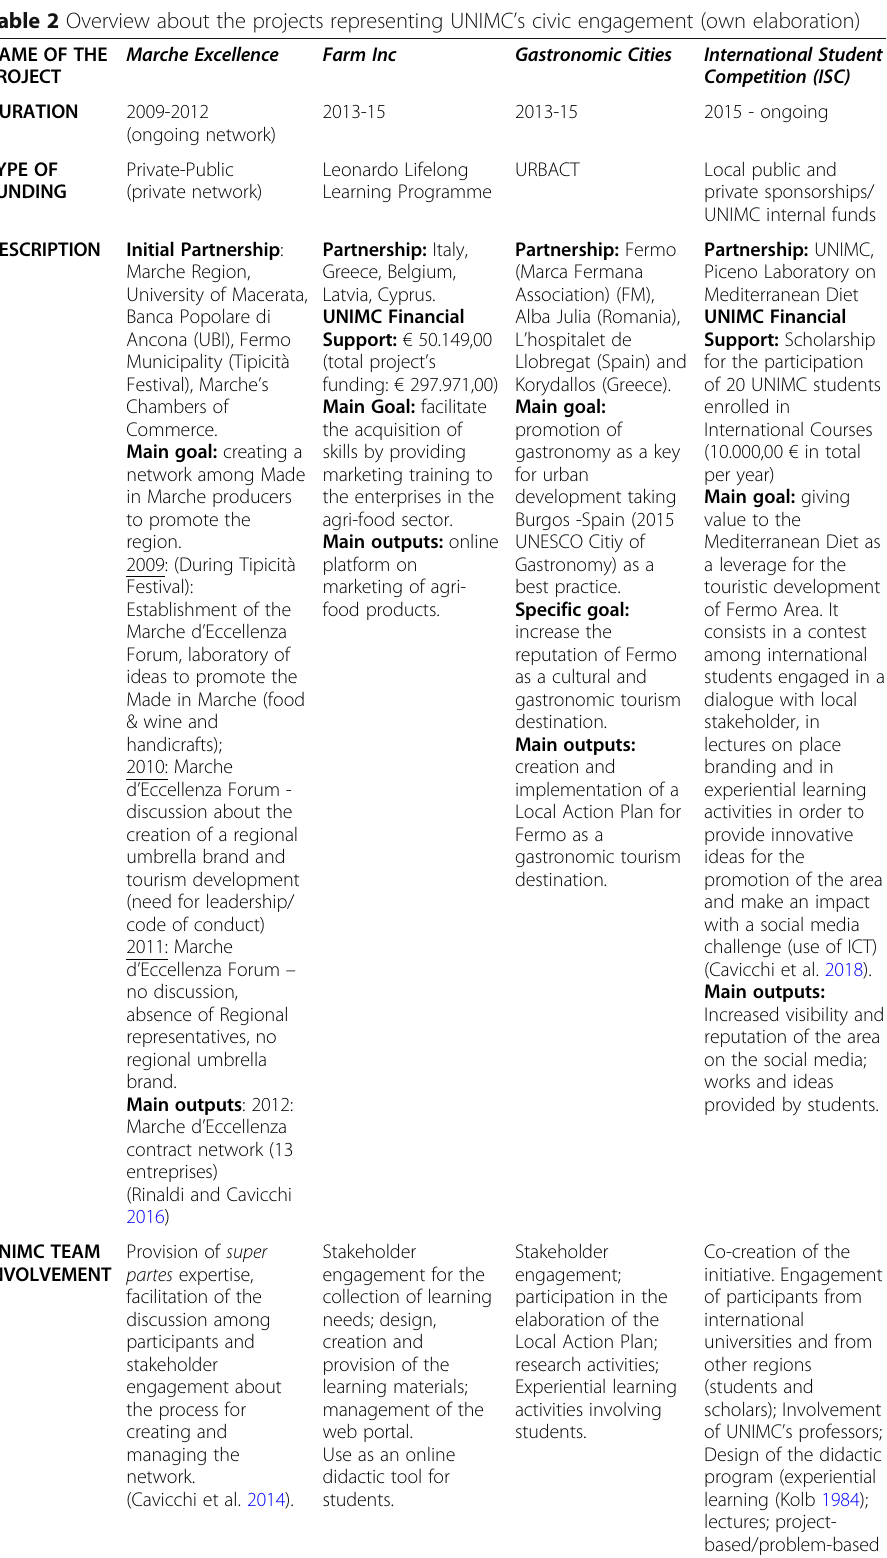
Table 2 Overview about the projects representing UNIMC ’ s civic engagement (own elaboration) NAME OF THE